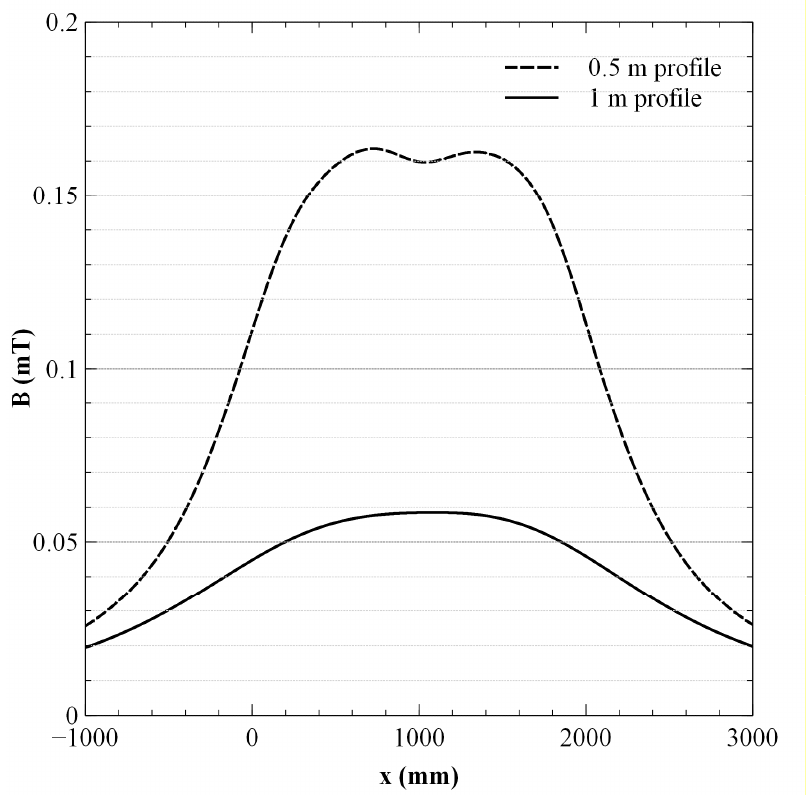
Figure 5. Distribution of the RMS values of the total magnetic flux density at the field points of the two observational profiles.